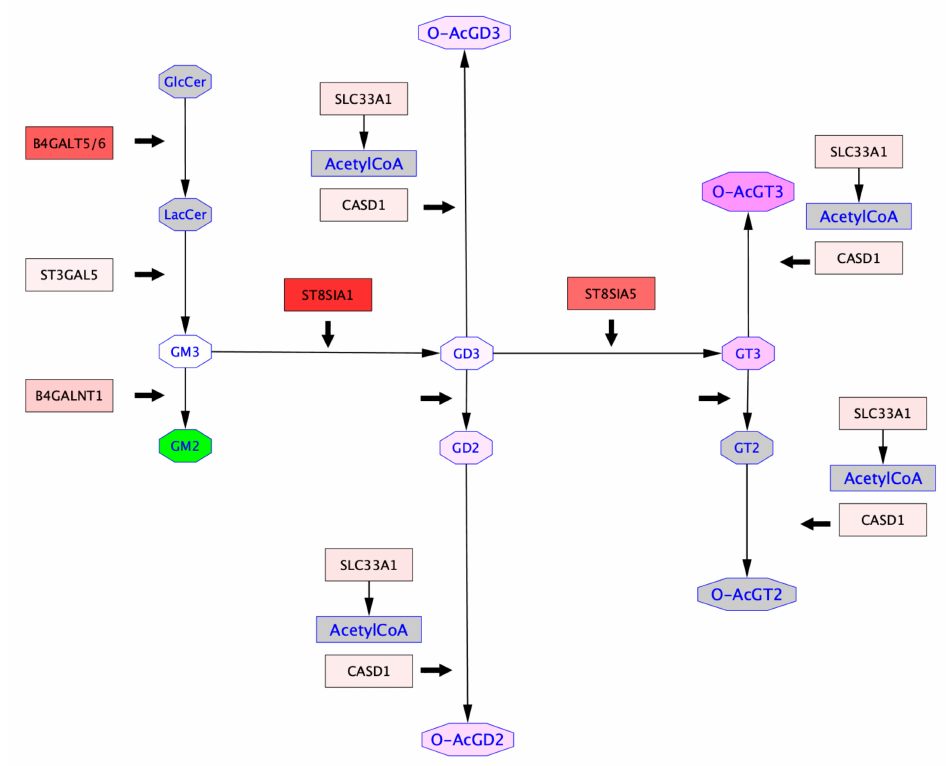
Figure 7. Di ff erential ganglioside metabolism pathways between MDA-MB-231 GD3S + clone #4 and MDA-MB-231 breast cancer cells. Glycosyltransferase gene expression profile obtained by qPCR were mapped onto a subpart of the “Ganglio-sphingolipid metabolism” pathway from WikiPathways [18,19] based on the di ff erential expression between two cell lines. In the squared nodes, colors vary from blue ( ≤ − 2) to white ( = 0) and red ( ≥ 2) to indicate the repression to the over-expression of the glycosyltransferase gene in MDA-MB-231 GD3S + clone #4 compared to MDA-MB-231 cells (thick black arrows). Quantitative data concerning the relative amounts of gangliosides obtained by MALDI-QIT-TOF mass spectrometry were added to the pathway based on the comparison between MDA-MB-231 GD3S + clone #4 and MDA-MB-231 cells. In the octagonal nodes, colors vary from green ( ≤ − 8) to white ( = 0) and fuchsia ( ≥ 8) to indicate a restraint to a rise of the amount of a given ganglioside based on the di ff erences observed between the two cell lines. Grey color indicates the absence of any available quantitative data about the